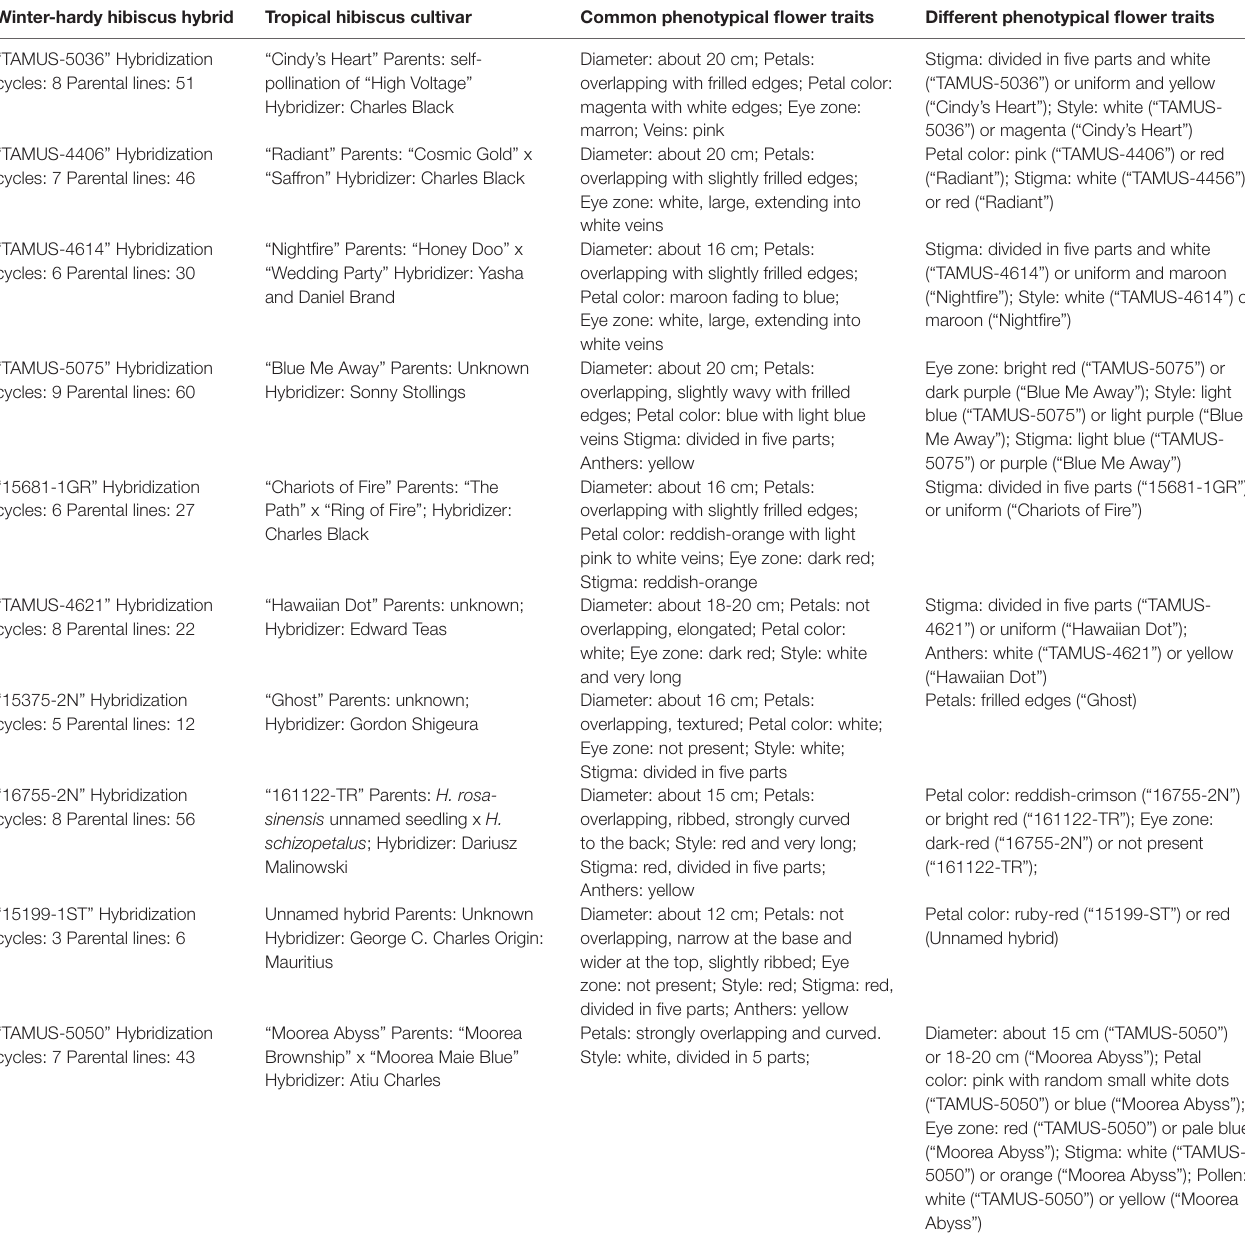
TABLe 2 | Summary of common and different phenotypical flower traits in winter-hardy hibiscus hybrids resembling tropical H. rosa-sinensis